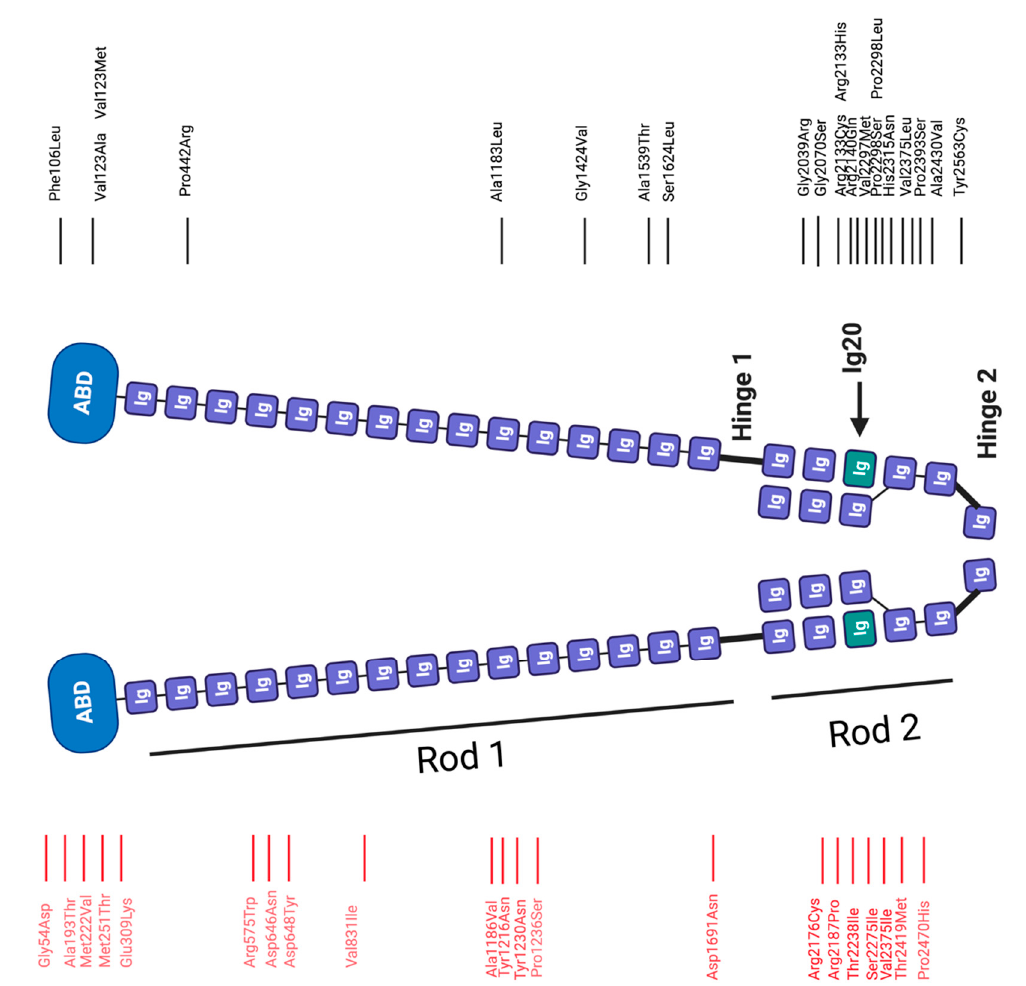
Figure 2. Schematic representation of Filamin C shown as a dimer with missense variants in the FLNC gene that have been previously reported in individuals with myopathy (red) or cardiomyopathy (black). ABD—actin binding domain, Ig—immuno-globulin like domain. For truncating variants, please refer to Table 2. Created with BioRender.com (access on 07/03/3021).